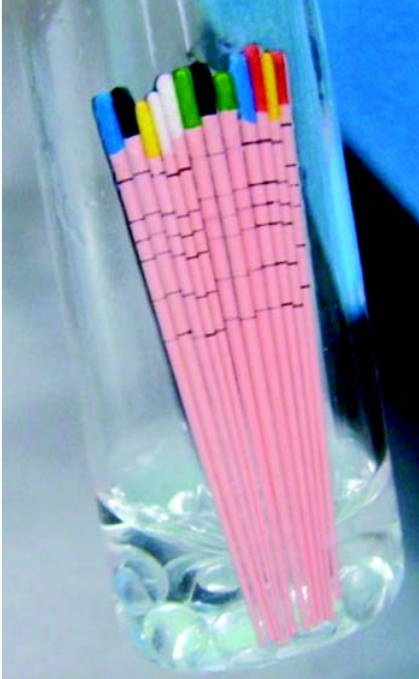
FIGURE 1- Gutta-percha cones (#15-40) sampled in a tube in the presence of glass beads and